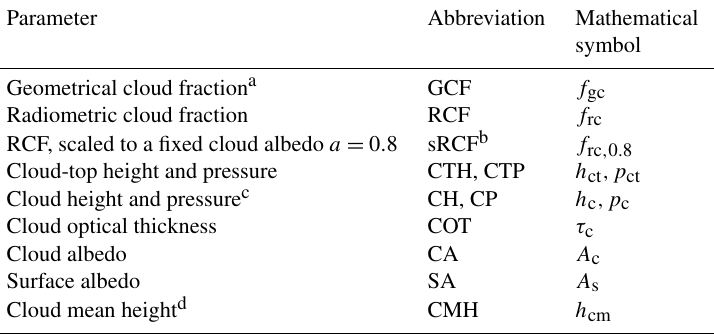
Table 1. Properties, abbreviation, and mathematical symbol.